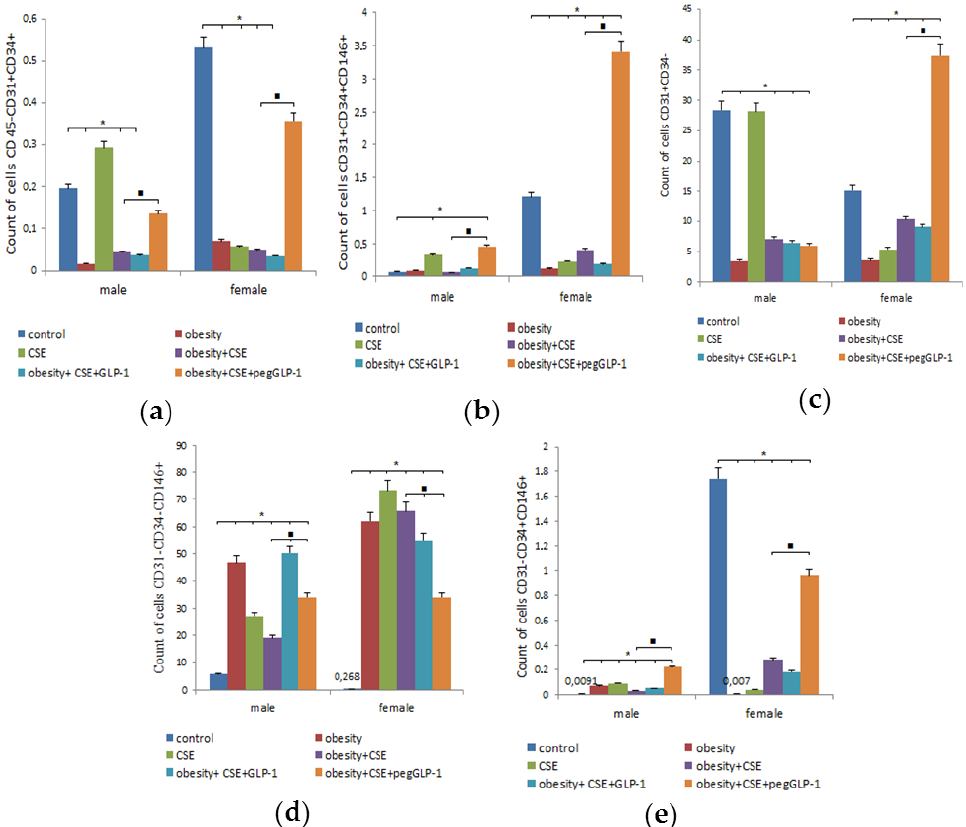
Figure 8. Characterization of cell population isolated from the blood of male and female C57BL / 6 mice on the p189. ( a ) The content of EPC (CD45 − CD31 + CD34 + ); ( b ) The content of EPC (CD31 + CD34 + CD146 + ); ( c ) The content of cells in the lumen of the nascent vessel (CD31 + CD34 − ); ( d ) The content of pericytes (CD31 − CD34 − CD146 + ); ( e ) The content of vascular smooth muscle cells (CD31 − CD34 + CD146 + ). Cells were analyzed by flow cytometry using antibodies for CD45, CD31, CD34, CD146 mice. Dot plots are representative of three independent experiments with the mean from three independent